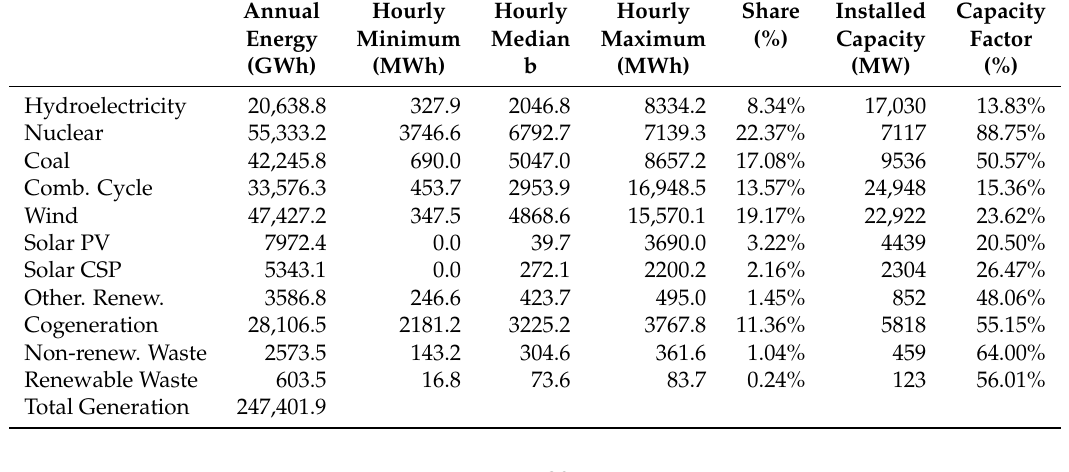
Table 1. Electricity generation by source in Spain for 2017. Source: Reference [11].